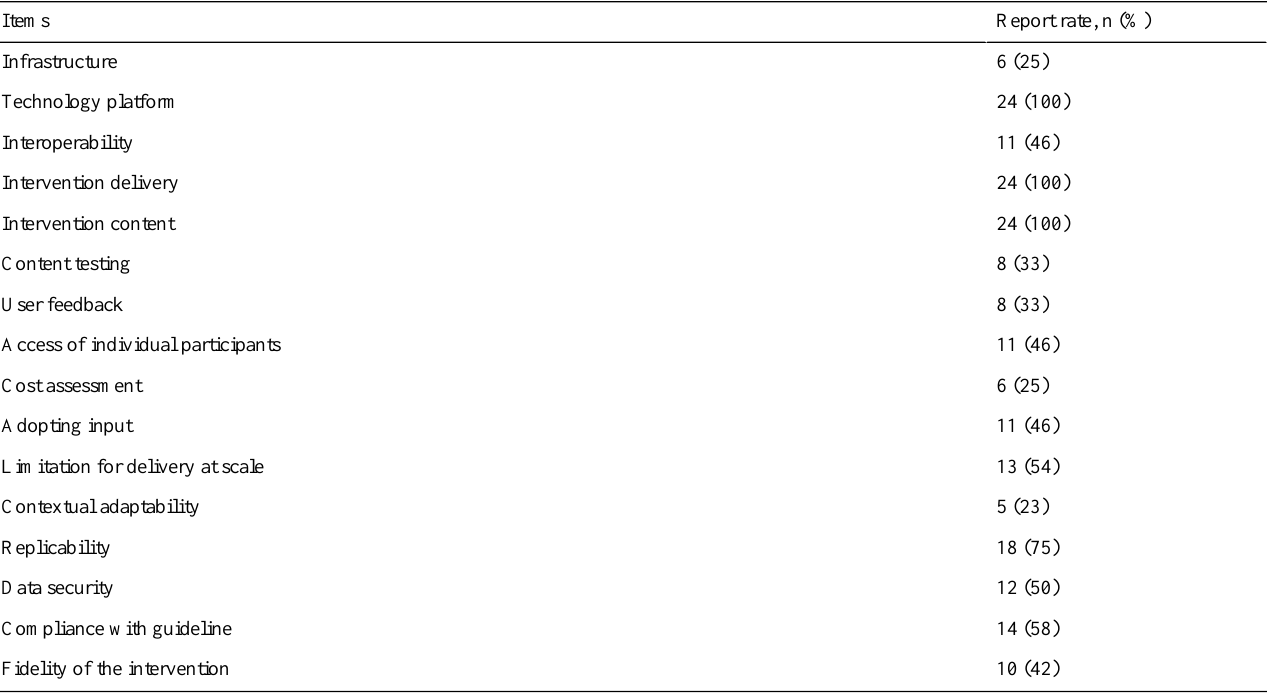
Table 2. Rate of reporting of each item in the Mobile Health Evidence Reporting and Assessment essential criteria checklist